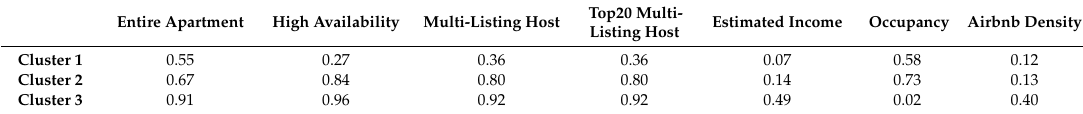
Figure 4. ANOVA boxplots variables for each cluster. Source: author’s own elaboration. Table 5. Means (centroid) of each variable by